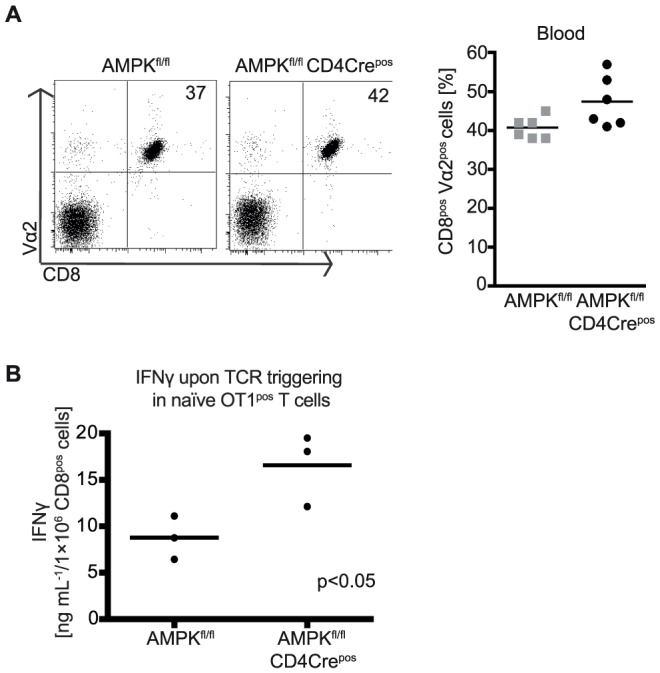
AMPK is not required for T cell development in a TCR-transgenic model.(A) Blood biopsies were immune-phenotyped for the co-expression of the Vα2 TCR chain and CD8 and the frequency of Vα2pos CD8pos cells was determined in OT-1 TCRpos AMPKα1fl/fl CD4Creneg and CD4Crepos mice (n = 6). (B) Equal numbers of CD8pos OT-1 TCRpos AMPKfl/fl CD4Creneg and CD4Crepos lymphocytes were activated with 0.5 µM SIINFEKL peptide for 18 h. Supernatants were collected and subjected to ELISA for the detection of soluble IFNγ secreted by activated T cells. Data summarise mean amounts of IFNγ of three mice analysed in technical triplicates. Statistical differences as indicated were determined using Mann-Whitney test.